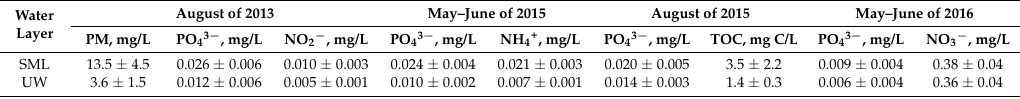
Table 1. Turbidity and chemical composition of SML and UW in Lake